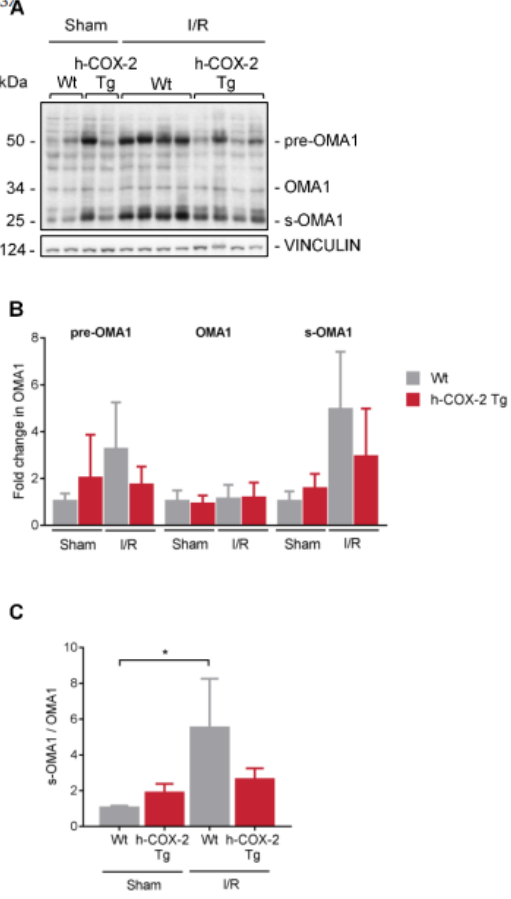
Figure 6. Analysis of OMA1 expression and activity. (A) Representative Western Blot of OMA1. (B) Densitometry quantification of the different forms of OMA1: pre-OMA1, OMA1 (mature form) and s-OMA1 (short form). (C) Ratio between the short form (s-OMA1) and the mature form (OMA1). Bars are means ± SD of three to nine independent measures. Statistical test: one-way ANOVA, followed by Tukey’s posthoc test. * p < 0.05.